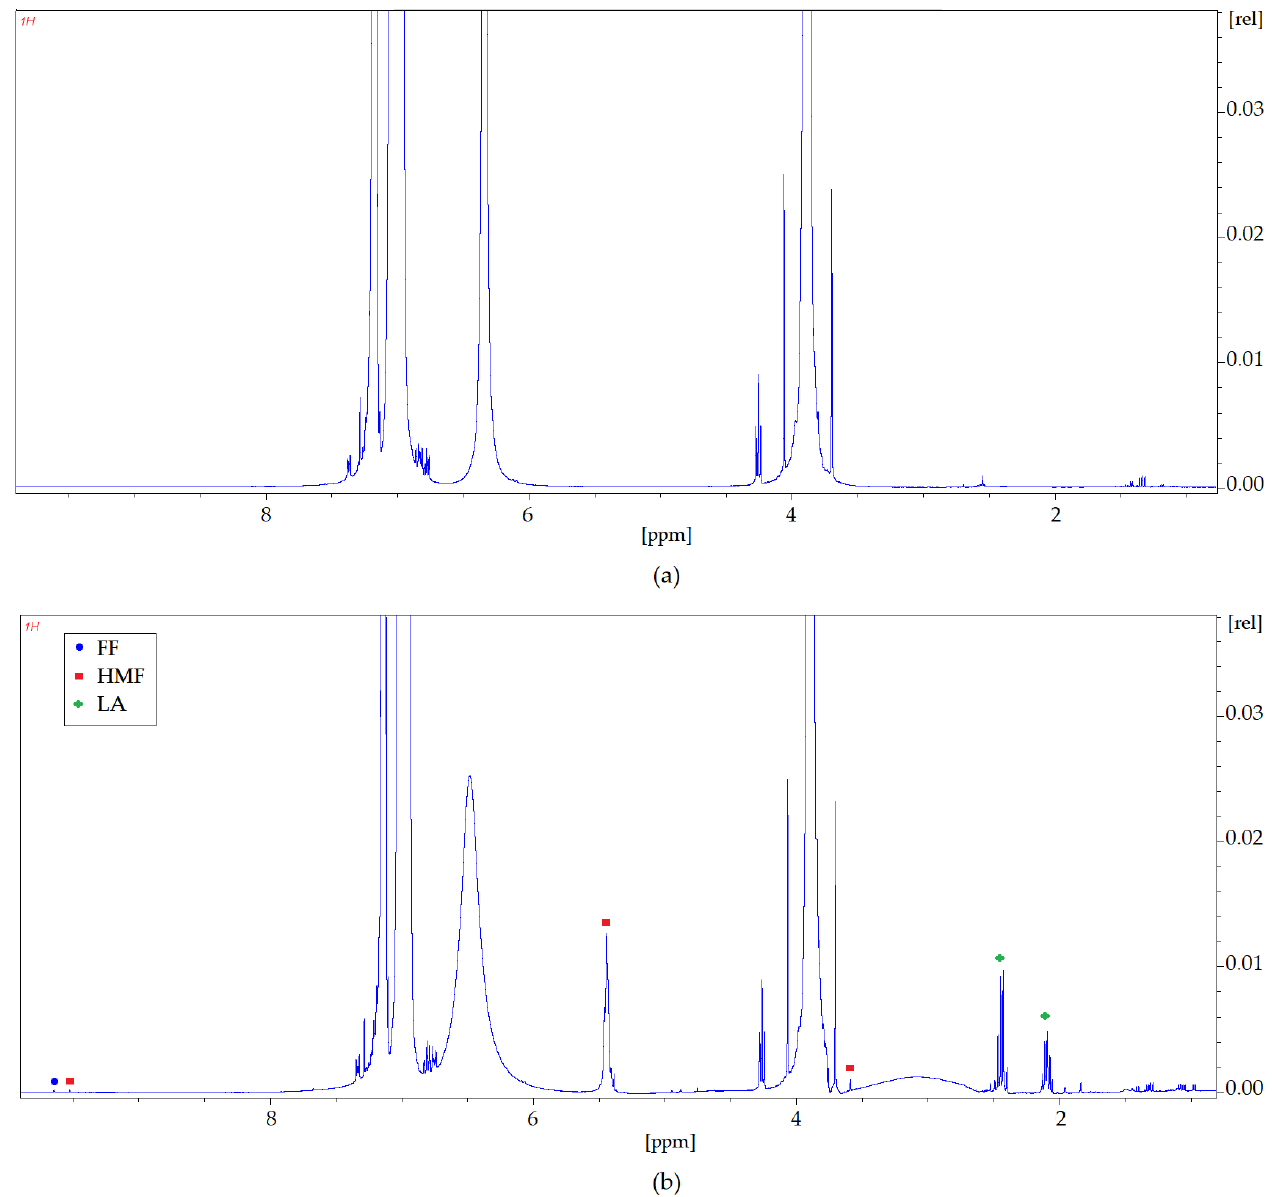
Figure 11. 1 H NMR spectra zoom ( a ) before the extraction process; ( b ) after the extraction process for pure Gu.